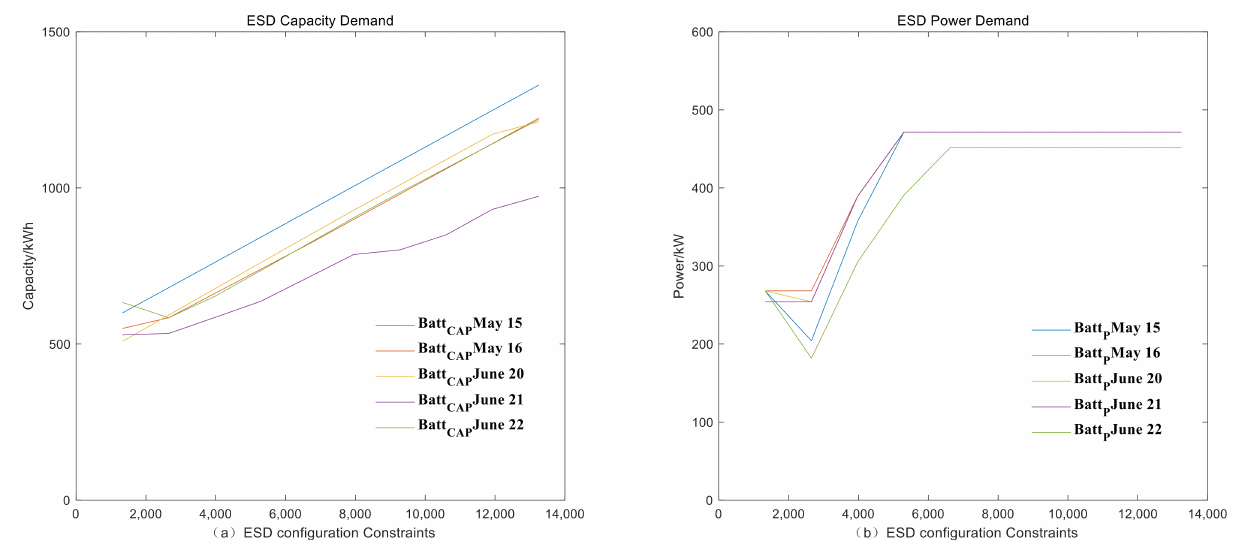
Figure 14. Actual configuration requirements of energy storage device.